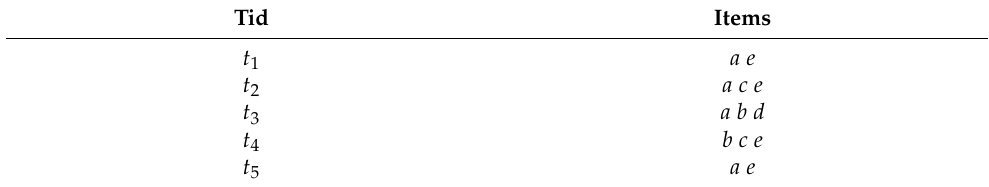
Table 1. A transaction database D